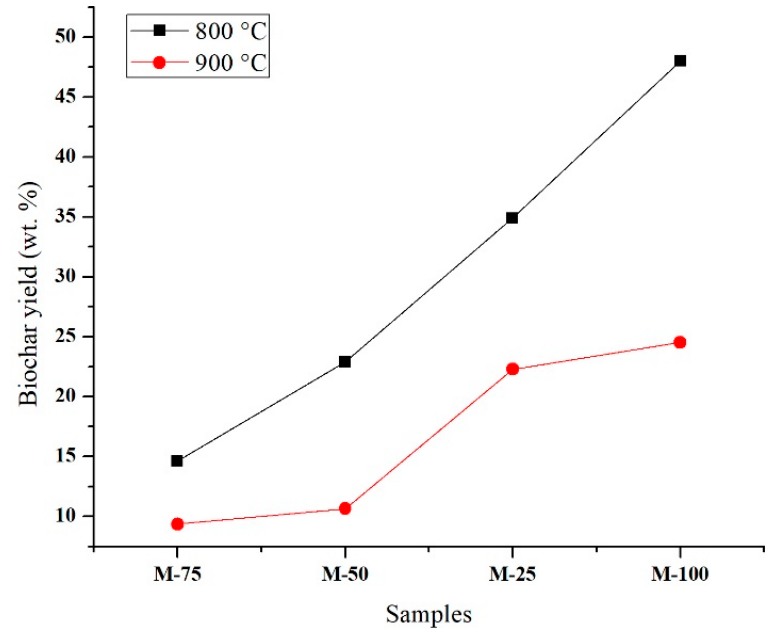
Figure 2. Effect of temperature on samples M-100, M-25, M-50, M-75.